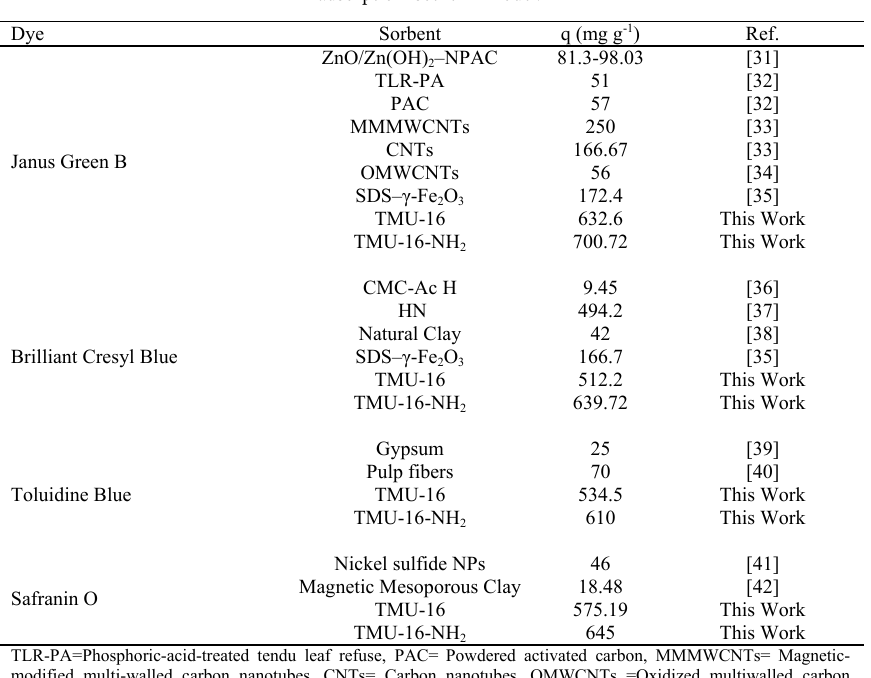
Table 4 Comparison of maximum dyes adsorption capacity of MOFs with previously reported sorbents obtained from Langmuir adsorption isotherm model. Dye Sorbent q (mg g -1 ) Ref.